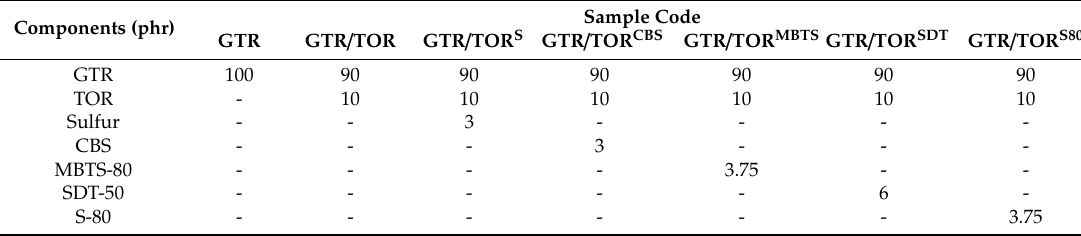
Table 2. The composition and coding of studied